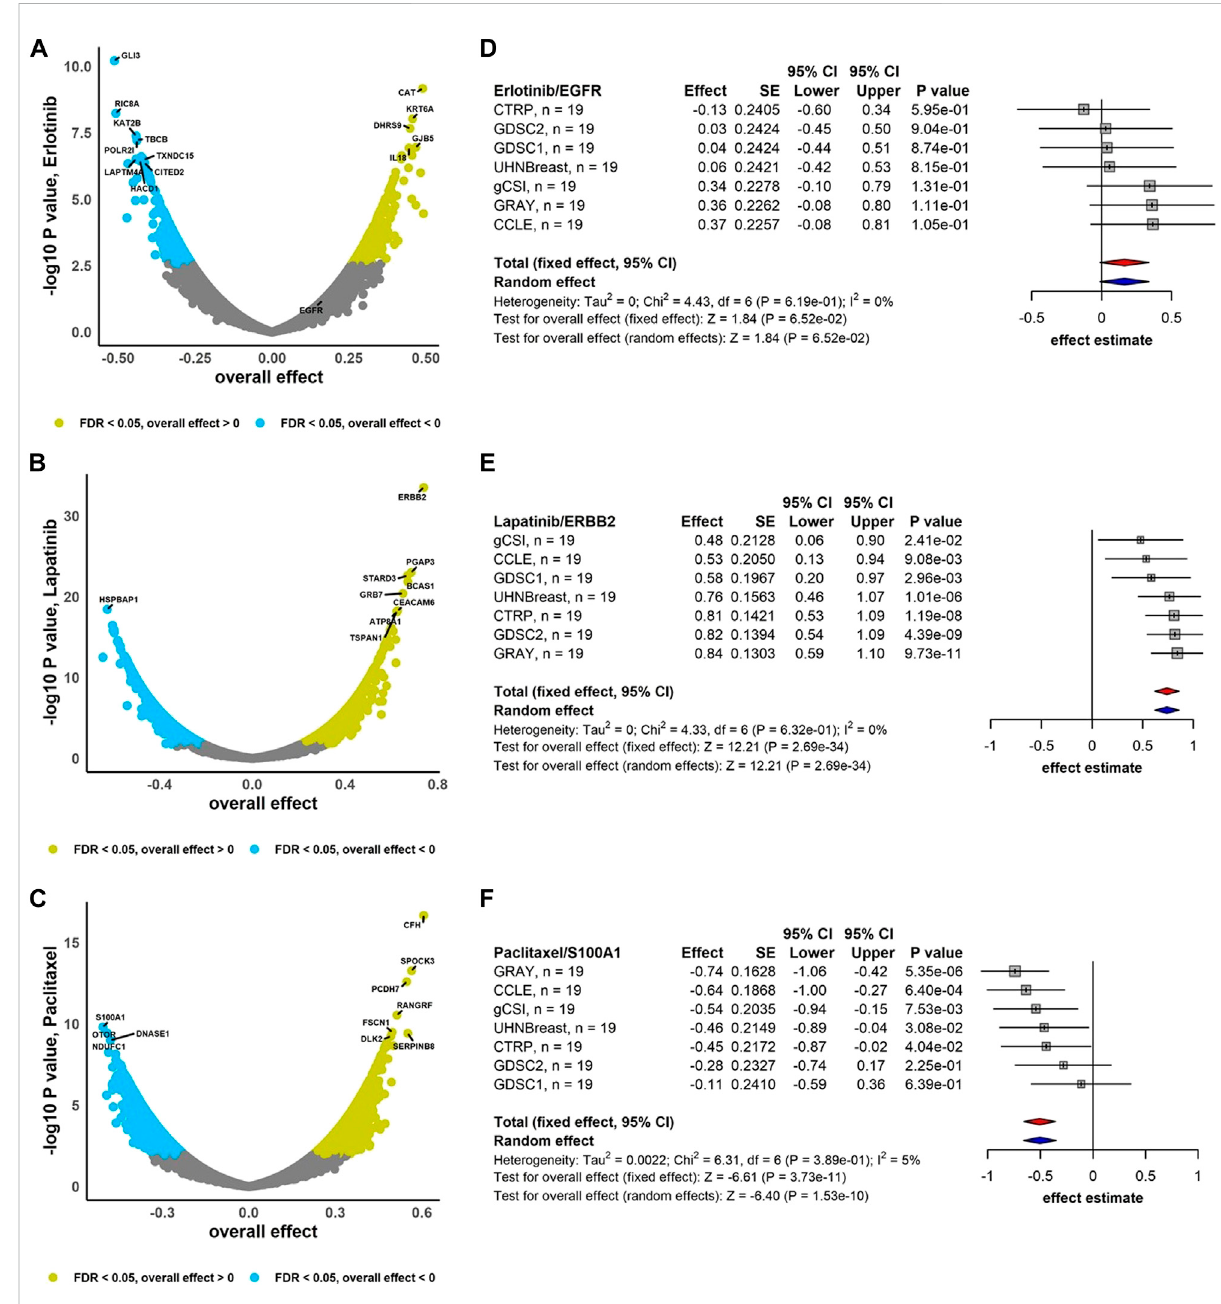
FIGURE 2 Breast cancer independent meta-analyses. Volcano plots show genes associated with drug response using RE meta-analysis model and forest plotsillustrateoveralleffectestimateusingFE(reddiamond)andRE(bluediamond)meta-analysismodelsusingdrugs (A) Erlotinib, (B) Lapatinib,and (C) Paclitaxel. DL approach was applied to estimate heterogeneity across